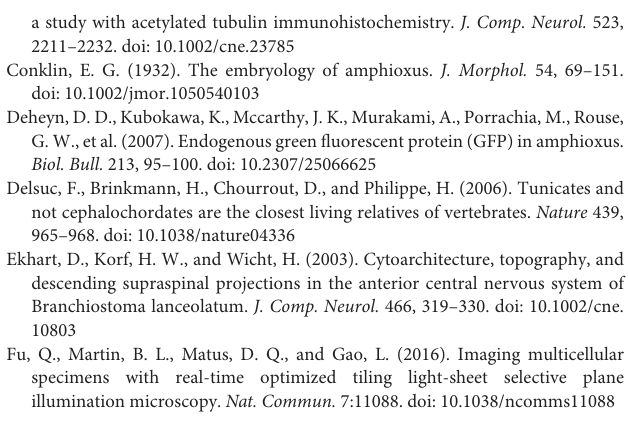
Supplementary Figure 1 | Selected optical sections show different types of neurons immunostained with anti-acetylated tubulin in 3-month-old juvenile (A-C”) and 6-month-old juvenile (D-E”) . (A-A”) Anteriolateral migrated cells. (B-B”) Translumenal cells. (C-C”) Somatic motoneurons. (D-D”) Lamellate cells. (E-E”) Retzius bipolar cells. Arrows in the individual panel point to indicated cell type. Faint vertical and horizontal lines indicate the plane of section. Supplementary Table 1 | Technical parameters of the imaging of amphioxus specimens. Supplementary Table 2 | Technical specification of analysis